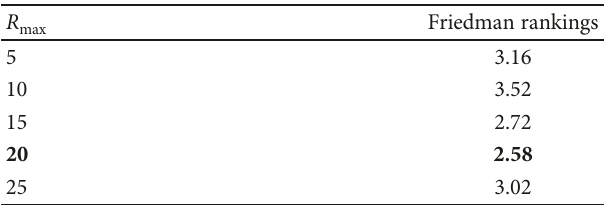
Table 13: Average Friedman rankings for the maximum number of random reinitialization. (a) Average Friedman rankings for the maximum number of random reinitialization on 25 benchmark functions